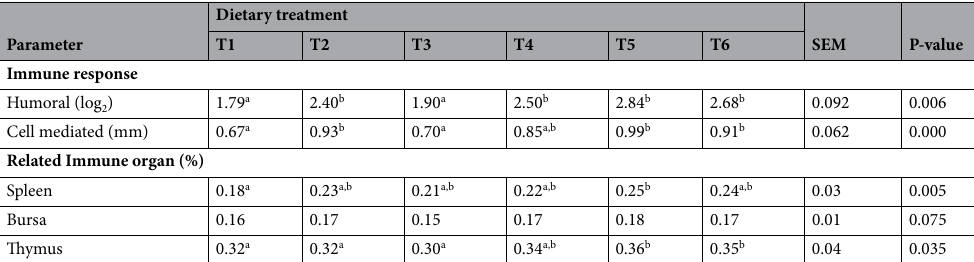
Table 3. Effect of dietary para-probiotic on immune response and relative immune organ (%) in broiler chickens. Mean values bearing the same superscript in a row did not differ significantly (P < 0.05). T 1 = control, T 2 = 0.02% CTC (w/v), T 3 = 0.2% PPB (w/v); T 4 = 0.4% PPB (w/v); T 5 = 0.6% PPB (w/v); T 6 = 0.8% PPB (w/v). CTC